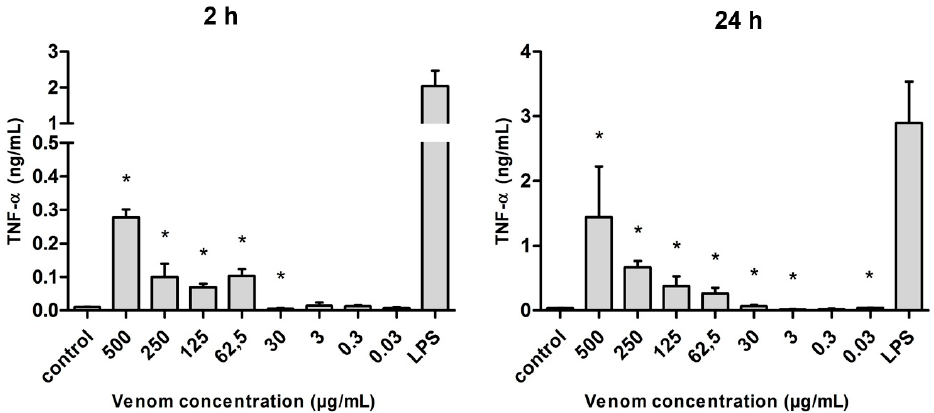
Figure 7. Amount of TNF- α (in ng/mL) released after the stimulus with Neoponera villosa venom. Values expressed in mean + standard deviation. Control: macrophages with supplemented culture medium alone. LPS: macrophages stimulated with 2 µ g/mL LPS. * Denotes significantly different ( p <